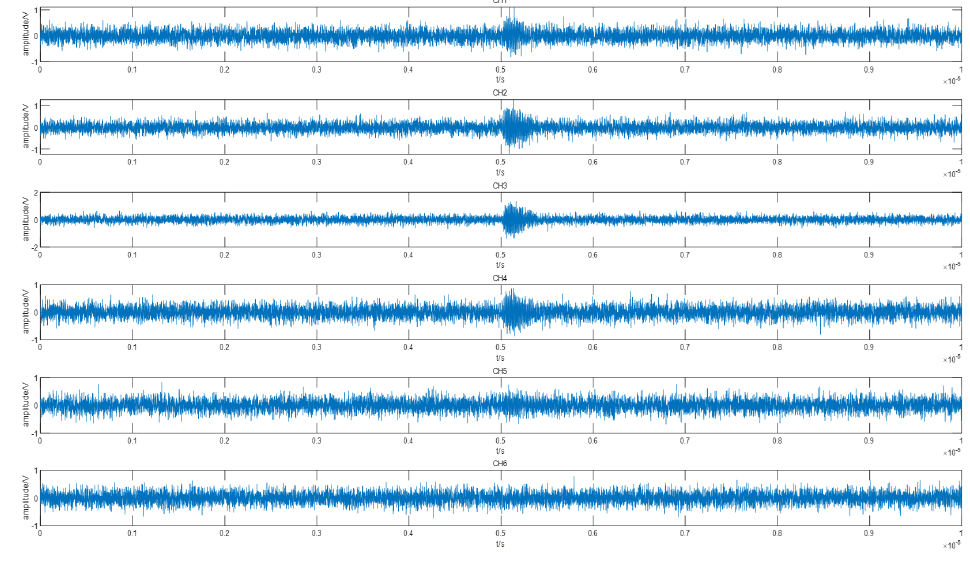
Figure 3. Waveform of 6-channel PD pulse after noise addition (SNR = − 10). The accuracy of the incoming wave direction estimation for different SNR is shown in Table 1. Table 1. Direction-finding accuracy under different SNR.